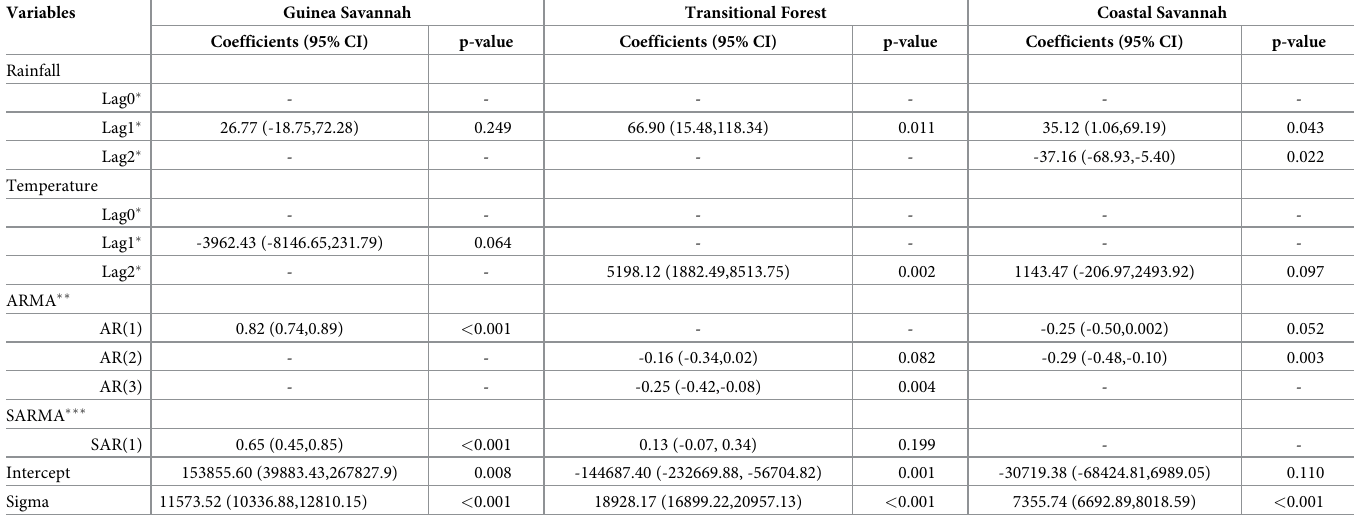
Table 2. Time series multivariable regression estimates of the relationship between average monthly rainfall, temperature and cases of malaria confirmed by zone.